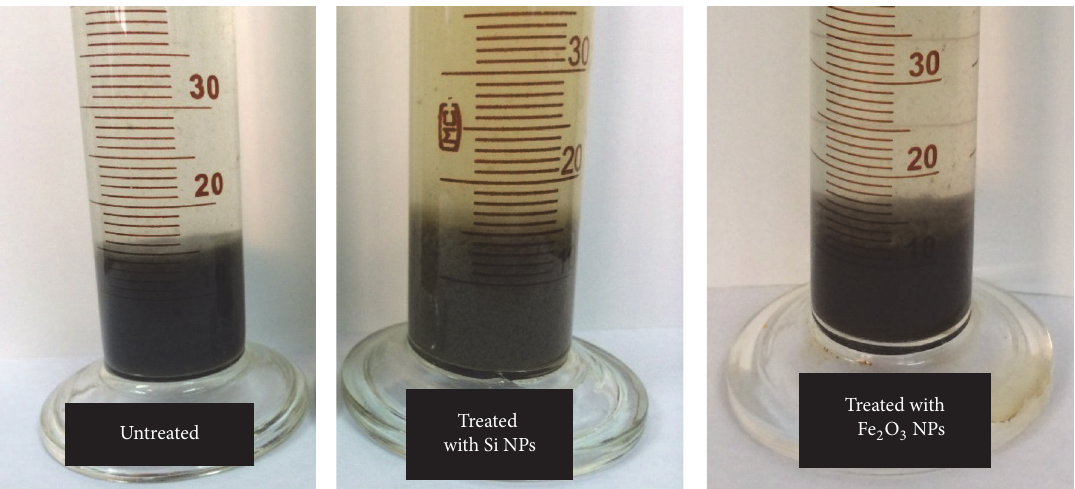
Figure 2: The sludge properties with addition of 50 mg/L Si NPs and 50 mg/L Fe 2 O 3